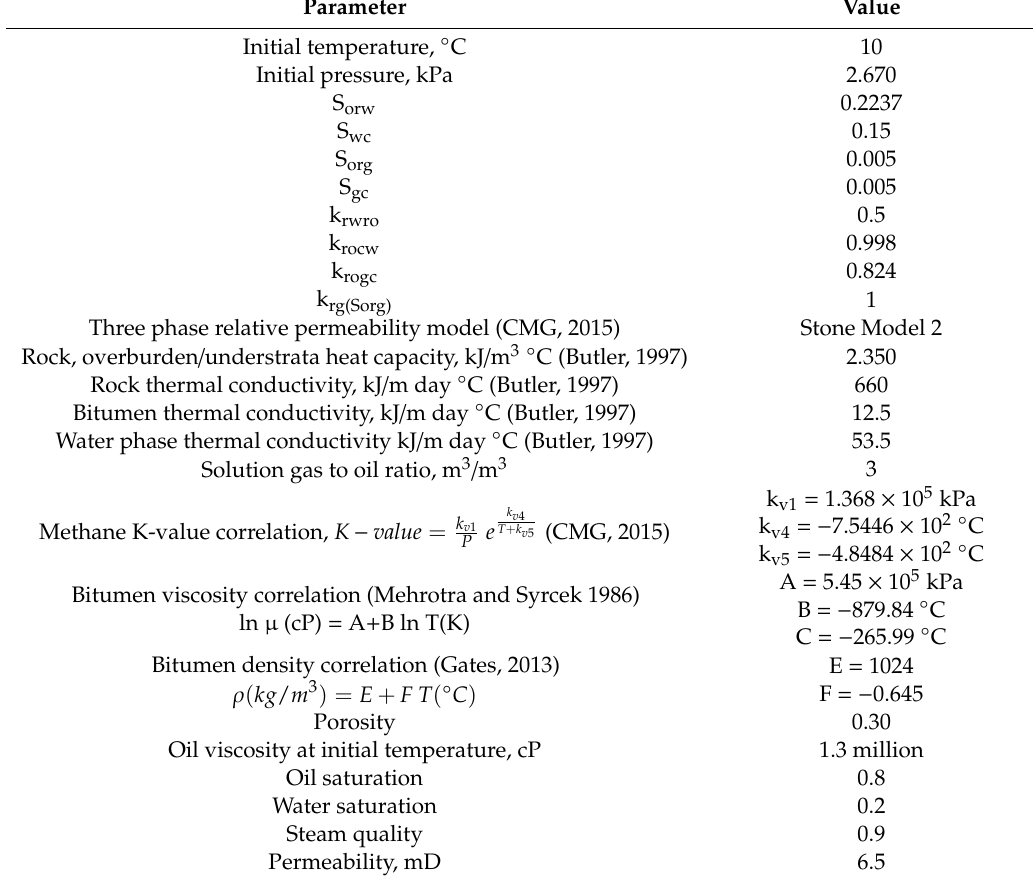
Table 1. Reservoir properties used in thermal reservoir simulation